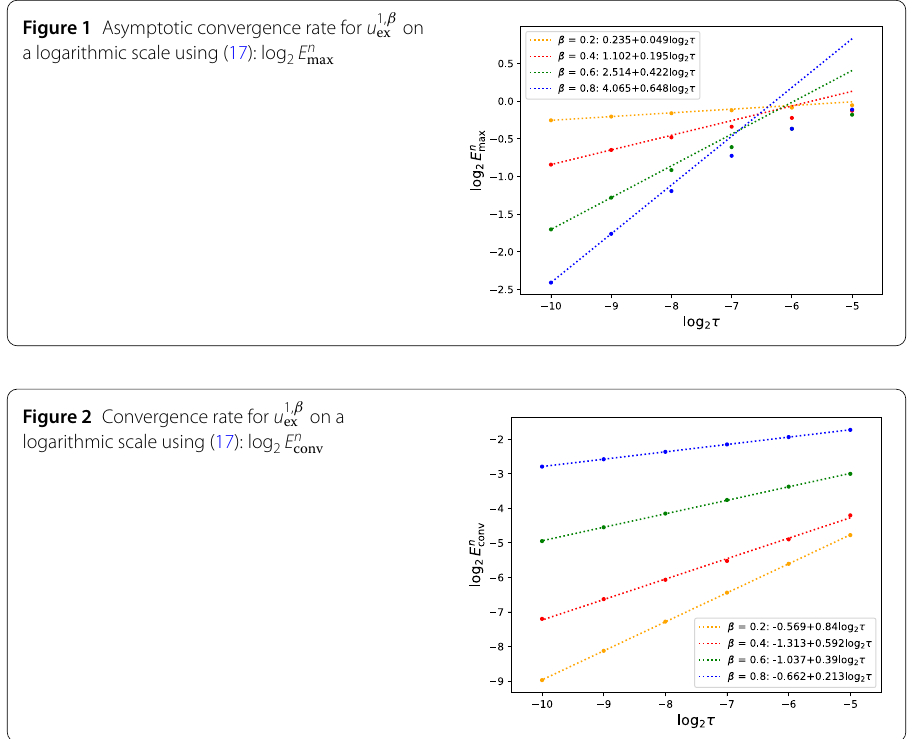
Figure 1 Asymptotic convergence rate for u 1, β ex on